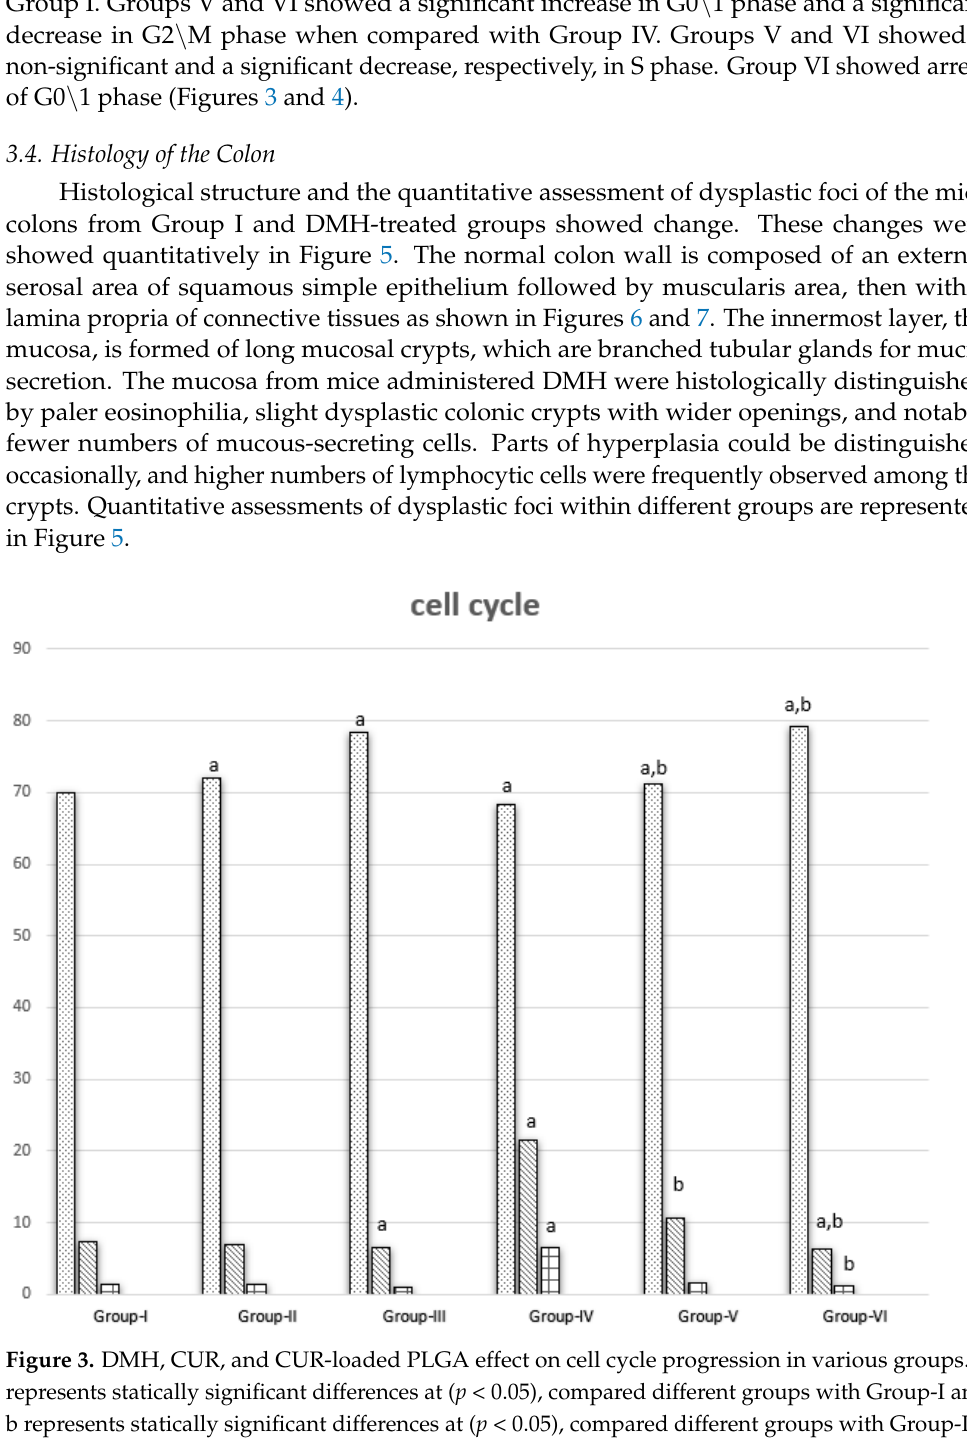
Figure 4. Histograms showing percentage (%) of cells in G0/1, S, and G2/M phases in different groups. 3.4. Histology of the Colon Histological structure and the quantitative assessment of dysplastic foci of the mice colons from Group I and DMH-treated groups showed change. These changes were